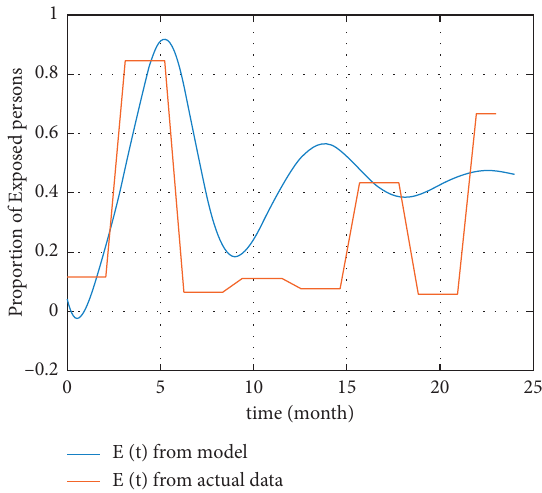
Figure 22: Proportion of expose curves from smoothing by bin medians data and the model. Table 8: Te relative error between the bin means data and the model